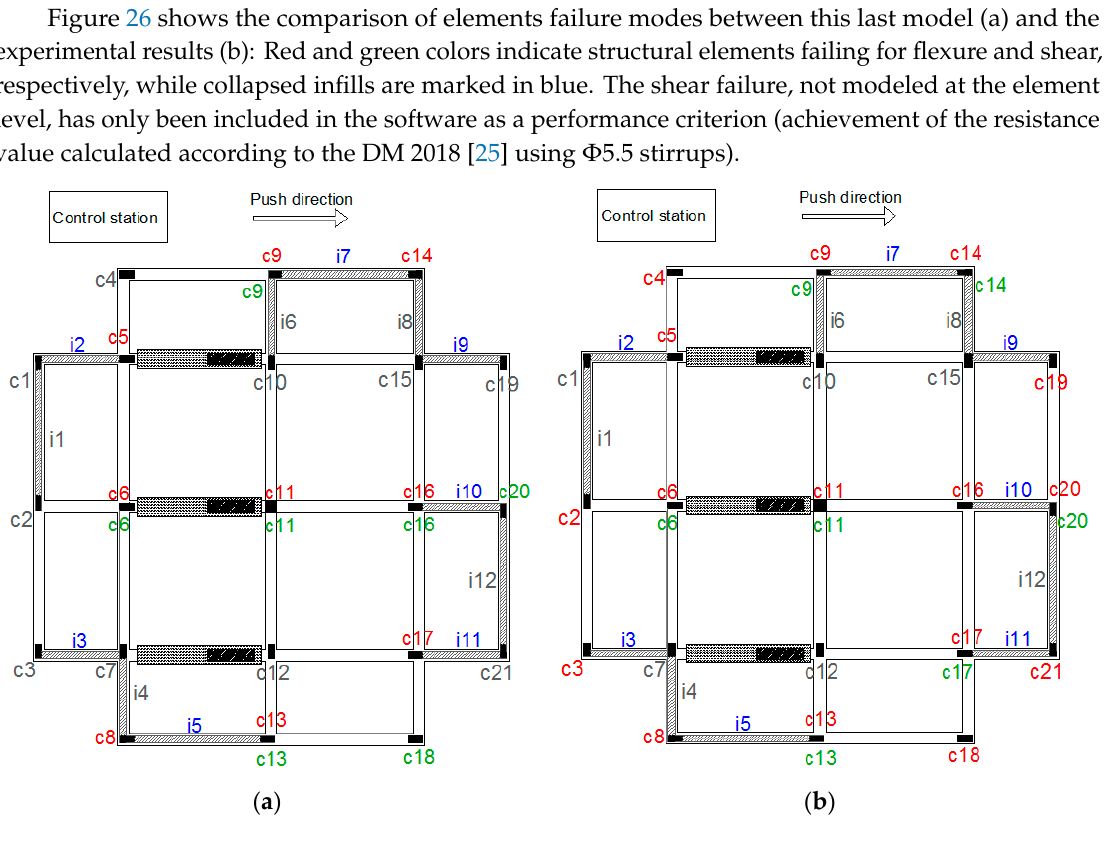
Figure 26. Element failure patter in the numerical model ( a ) and in experimental results ( b ) (red–flexure, green–shear, blue–infills collapse).